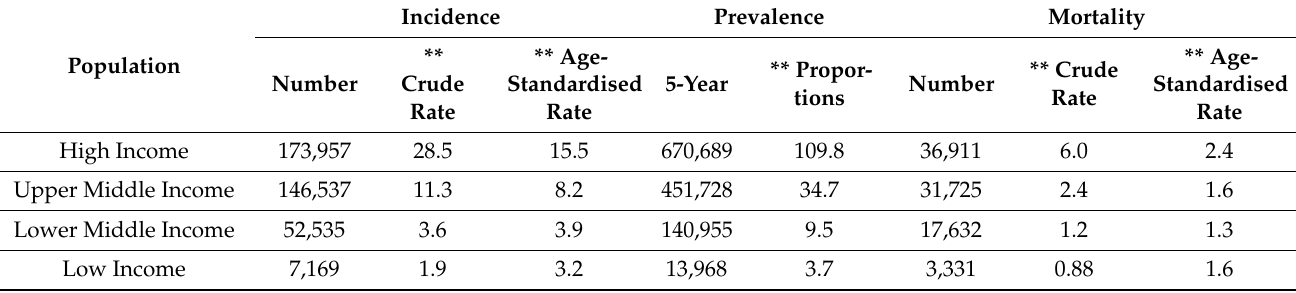
Table 1. The effect of income levels on the worldwide incidence, prevalence and mortality values for endometrial cancer in